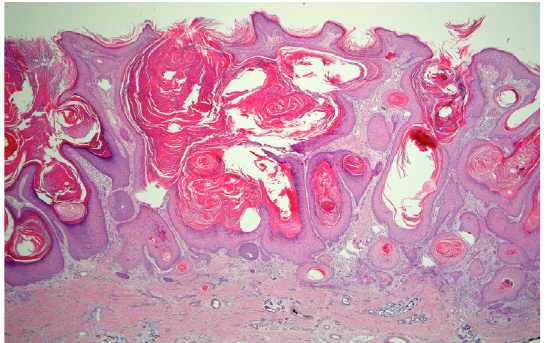
Figure 2. Biopsy specimen confirmation of Squamous Cell Carci- noma, Keratoacanthoma type from Patient’s Left Volar